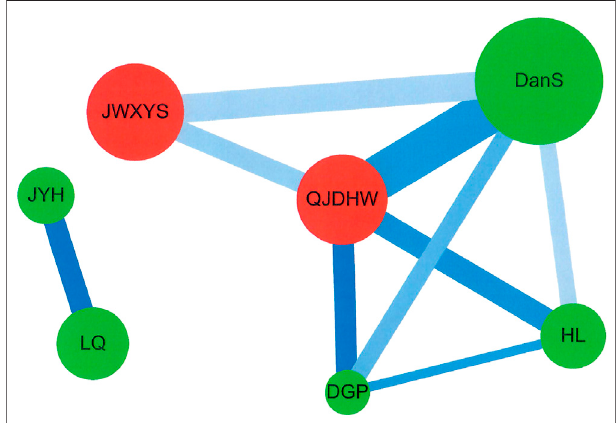
FIGURE 3 | Network analysis for CHM prescription pattern in patients with pemphigus. Abbreviations: CHM, Chinese herbal medicine.